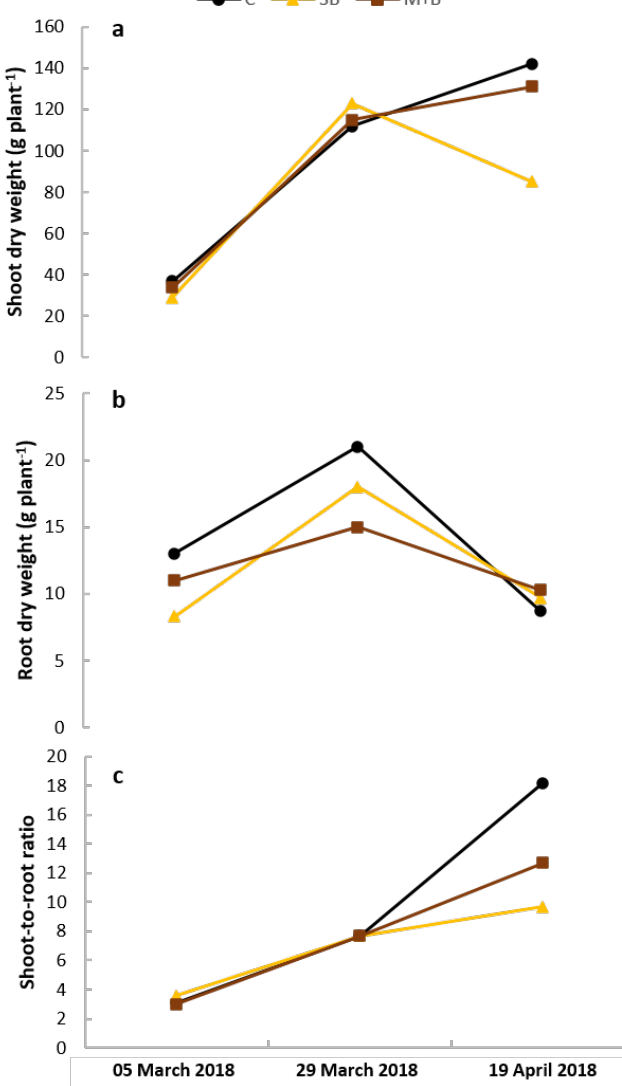
Figure 14. Biomass expressed in dry weight (g plant − 1 ) of shoots ( a ), roots ( b ) and shoot-to-root ratio ( c ) as a function of organic amendments (none (C), manure (M) and manure plus rice straw buried (M + SB)) at three crop stages (flowering, cob formation and maturity) within the furrow-irrigated treatment in the 2017/18 dry season.